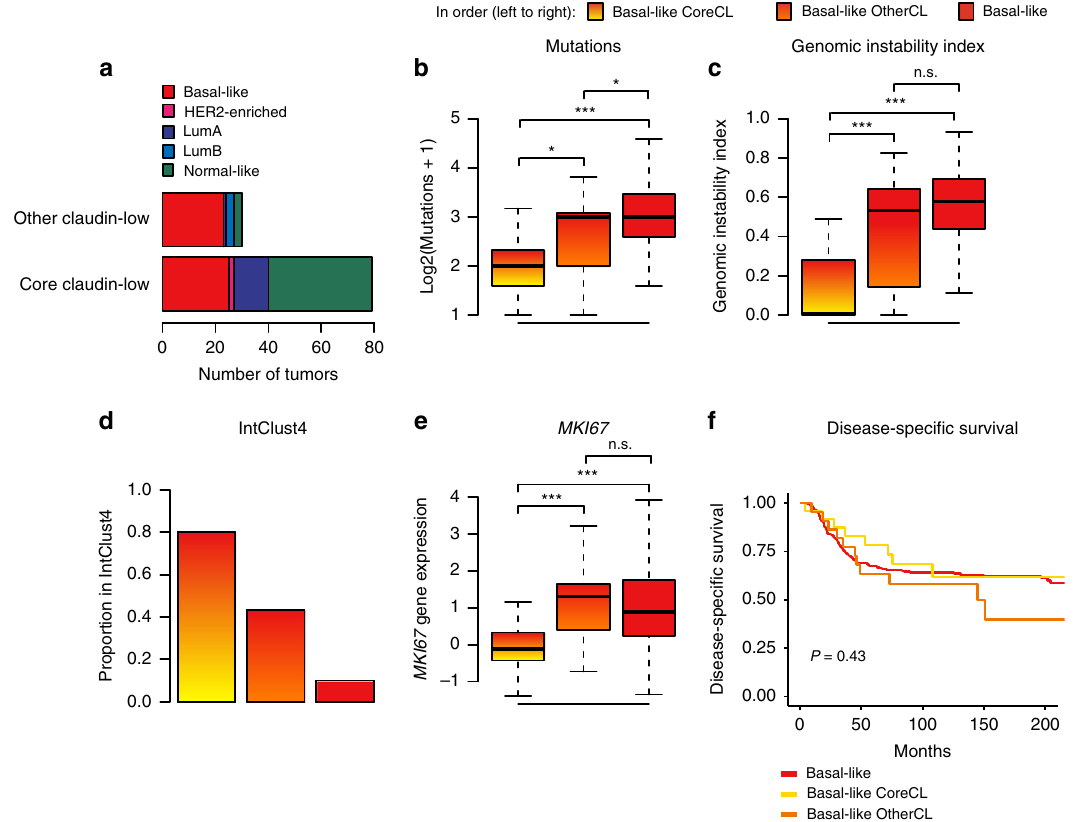
Fig. 4 Basal-like OtherCL tumors may be inappropriately classi fi ed as claudin-low. a Distribution of subtypes in CoreCL and OtherCL tumors in the METABRIC cohort. Hierarchical clustering with the condensed claudin-low gene list fi ltered out a subset of basal-like claudin-low tumors (as de fi ned by the nine-cell line predictor) with weak claudin-low characteristics. b Number of mutated genes in the panel of 173 sequenced genes. Basal-like CoreCL tumors carried signi fi cantly fewer mutations than basal-like OtherCL tumors and basal-like non-claudin-low tumors ( P = 0.02 and P < 0.001 respectively, two- tailed Wilcoxon rank-sum test). c Distribution of genomic instability index. Basal-like CoreCL tumors showed signi fi cantly lower levels of genomic instability than basal-like OtherCL tumors and non-claudin-low basal-like tumors ( P < 0.001 for both, two-tailed Wilcoxon rank-sum test). d Proportion of tumors in IntClust4. 80% of basal-like CoreCL tumors were classi fi ed as IntClust4. e MKI67 gene expression (log2). Basal-like CoreCL tumors expressed signi fi cantly lower levels of MKI67 than basal-like OtherCL and non-claudin-low tumors ( P < 0.001 for both, two-tailed Wilcoxon rank-sum test). f Disease- speci fi c survival in basal-like CoreCL, basal-like OtherCL and non-claudin-low basal-like tumors. Disease-speci fi c survival in basal-like breast tumors did not signi fi cantly differ when strati fi ed by claudin-low status (two-tailed log-rank test). Disease-speci fi c deaths: basal-like CoreCL n = 8 of 25, basal-like OtherCL n = 12 of 23, basal-like non-claudin-low n = 97 of 260. All n.s. P > 0.05, * P < 0.05, ** P < 0.01, *** P < 0.001. Boxplot elements: center line